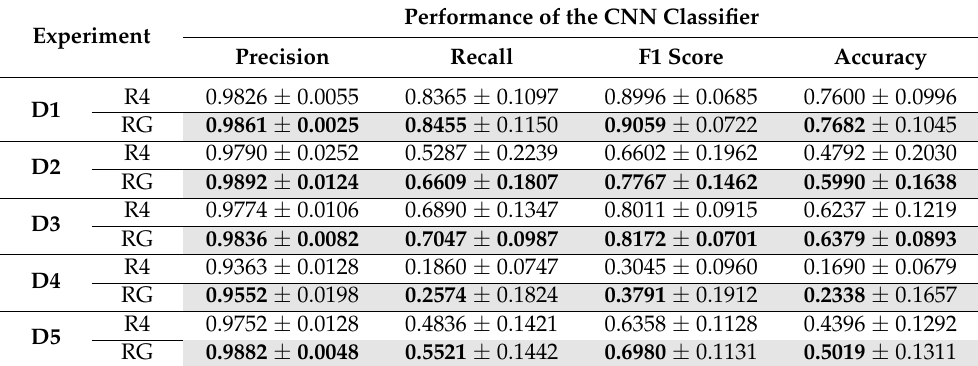
Table 16. The average results of testing each D experiment on an Unseen Drone. Performance of the CNN Classifier Experiment Precision Recall F1 Score Accuracy